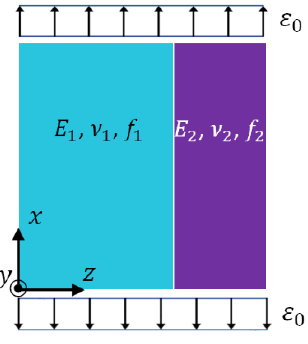
Figure A1. Iso-strain condition.